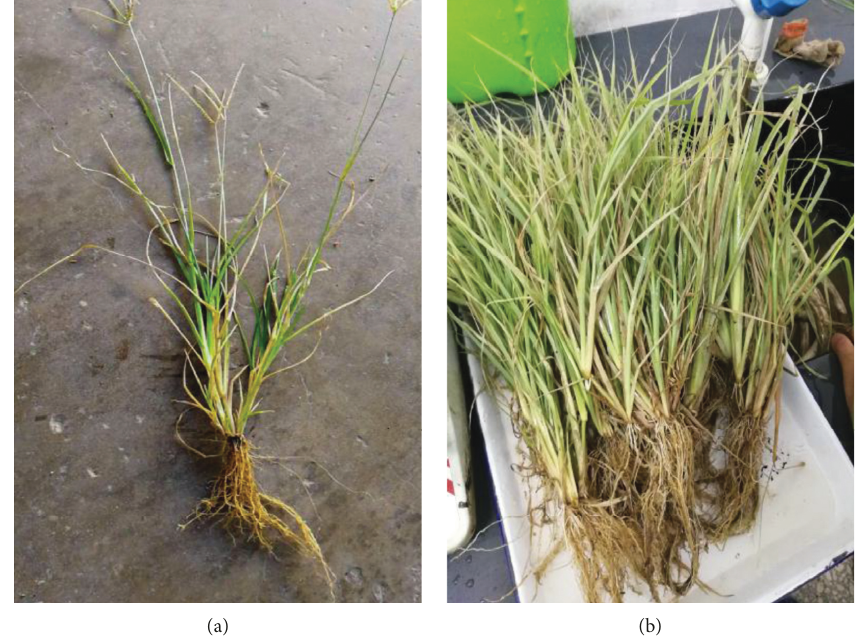
Figure 1: Photographs of the plant of interest. Table 1: Physical and mechanical parameters of the soil.